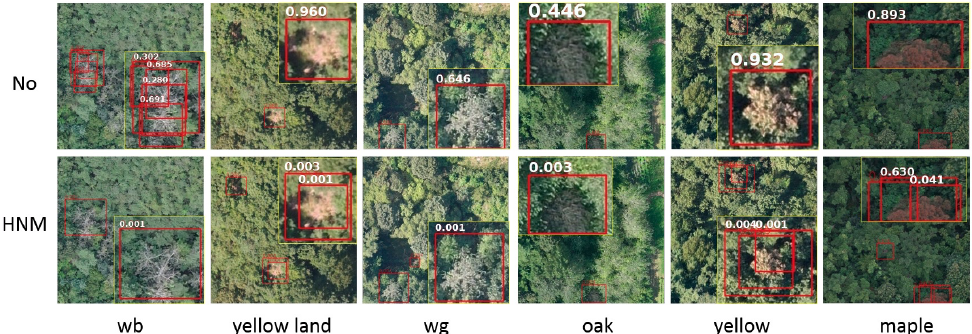
Figure 8. Advantage of using hard negative mining. The detector bounding boxes are the “disease- like” object (FP). For convenience, we zoomed out from the region of interest to highlight the difference when hard negative mining is